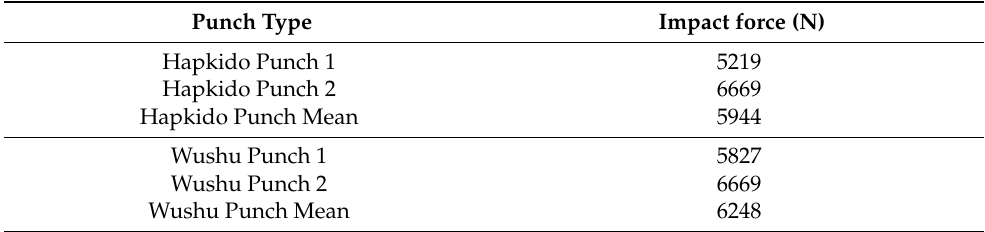
Table 4. Martial Arts styles comparison impact force results.